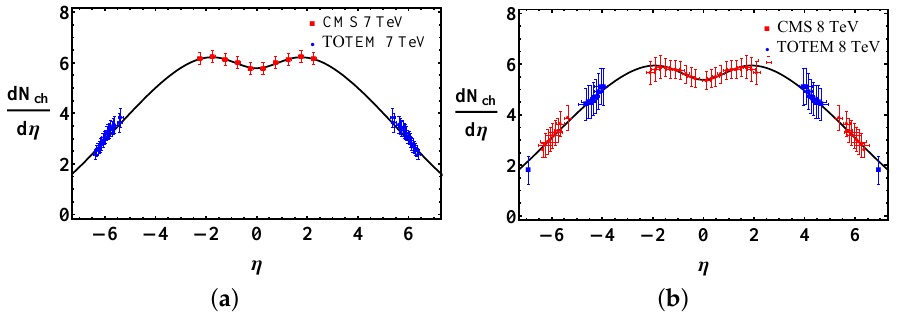
Figure 4. ( a ) Charged particle dN distributions from CMS [51] and TOTEM [66] at 7 TeV fitted with the d η result of our relativistic hydrodynamical solution described in this paper, with λ = 1.076; ( b ) Charged particle dN distributions from CMS and TOTEM 8 TeV data of Reference [62,67] fitted with our results, d η with λ =